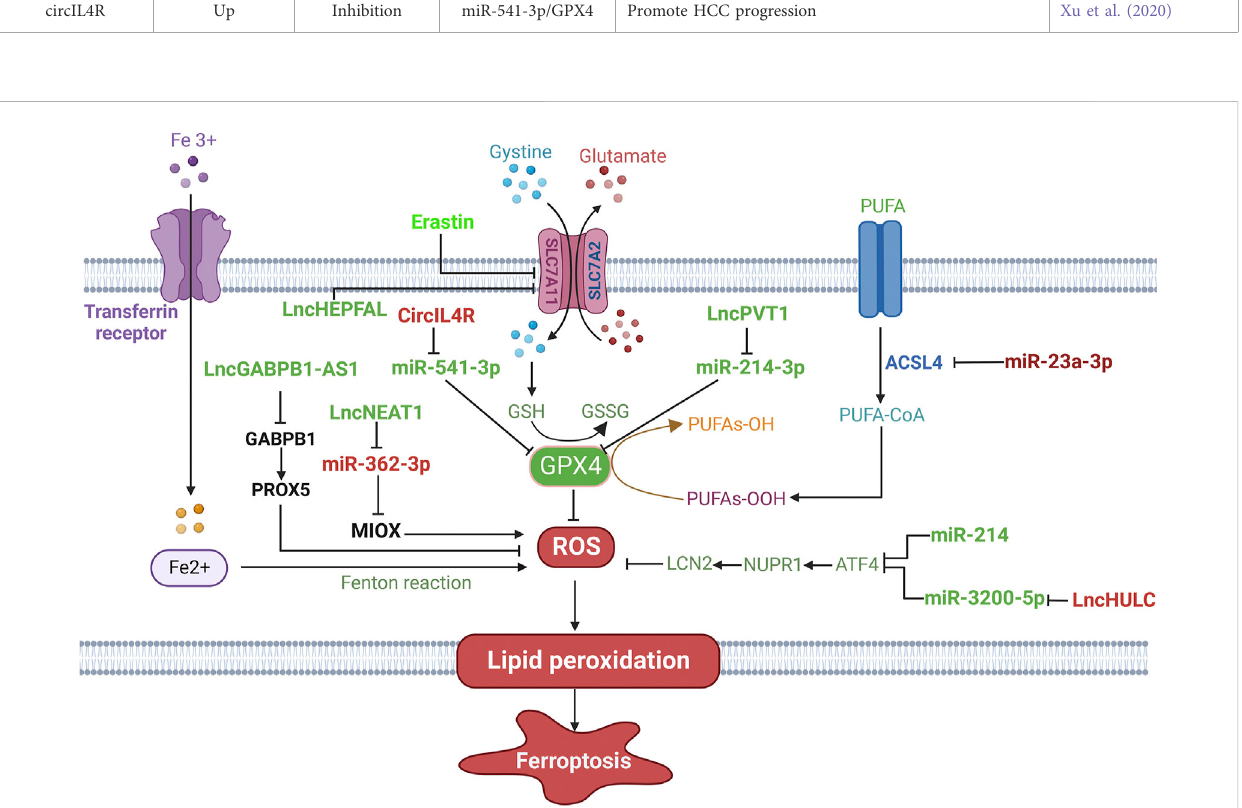
FIGURE 3 The regulatory role of ncRNAs on ferroptosis in HCC. Ferroptosis-promoting ncRNAs (green), such as lncHEPFAL, lncGABPB1-AS1 and lncNEAT1, regulate ferroptosis-related signaling pathways and components to induce ferroptosis. Ferroptosis-suppressive ncRNAs (red), including lncHULC, miR- 23a-3p and cirIL4R, inhibit ferroptosis through targeting the regulatory pathways of ferroptosis. → indicates a promoting effect and ⊥ indicates an inhibitory